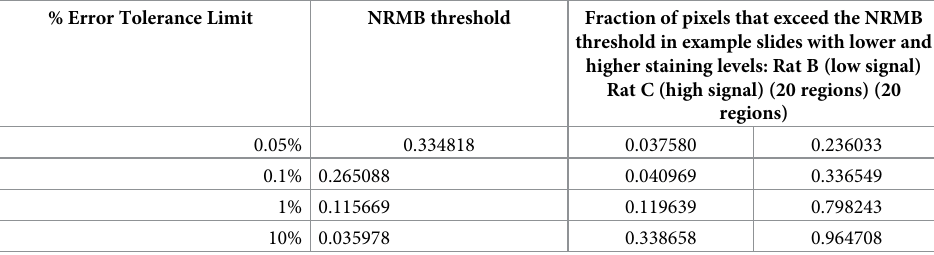
Table 2. Impact of error tolerance setting on fraction of pixels that exceed the resulting NRMB threshold for DAB